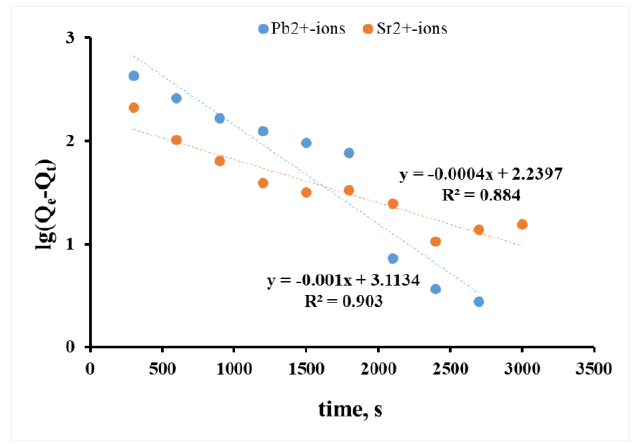
Figure 6. Sorption kinetics of Pb 2+ and Sr 2+ ions in the coordinates of the Lagergren pseudo-first-order.